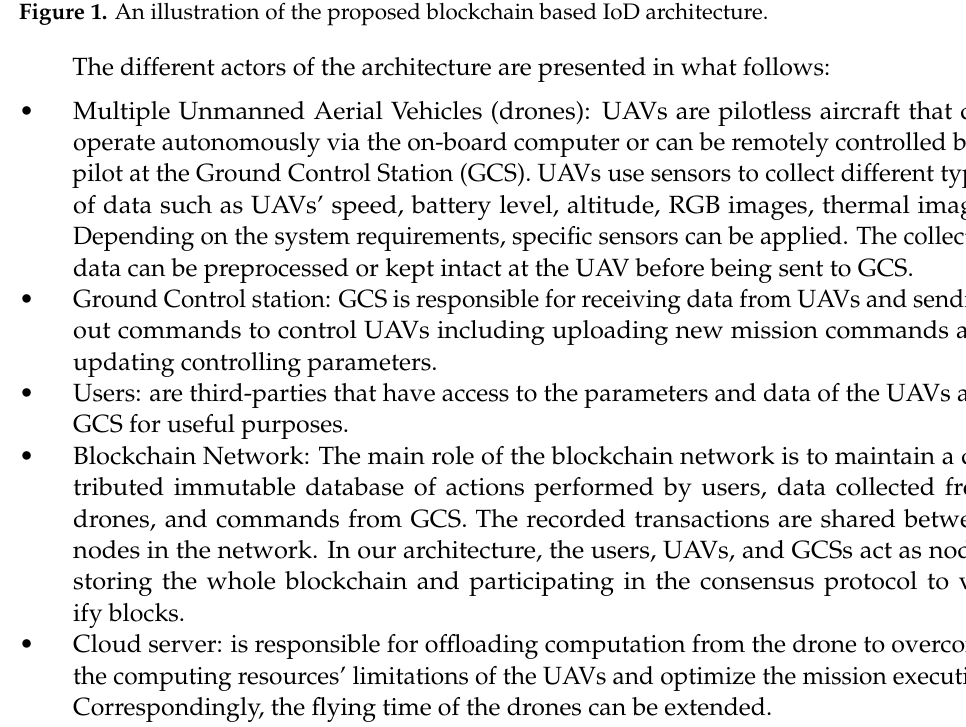
Figure 1. An illustration of the proposed blockchain based IoD